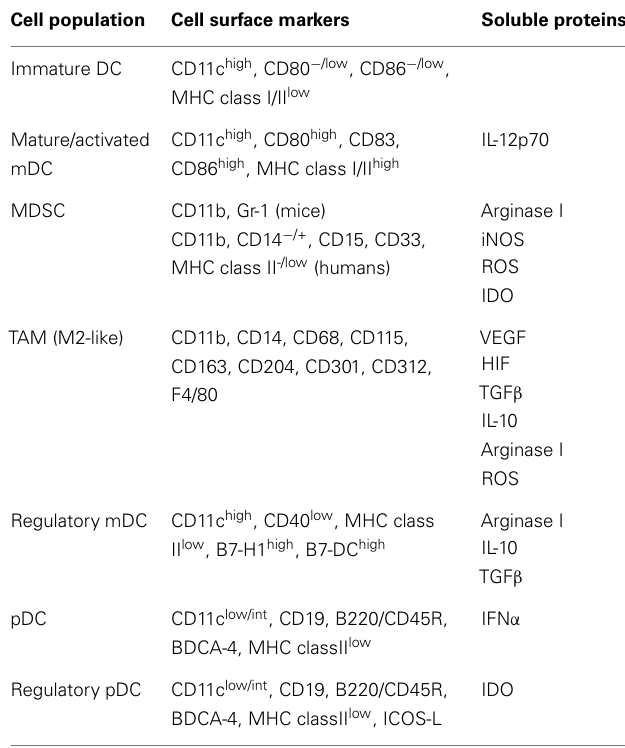
Table 1 | Phenotypic characteristics of tumor-associated DC and populations derived from DC